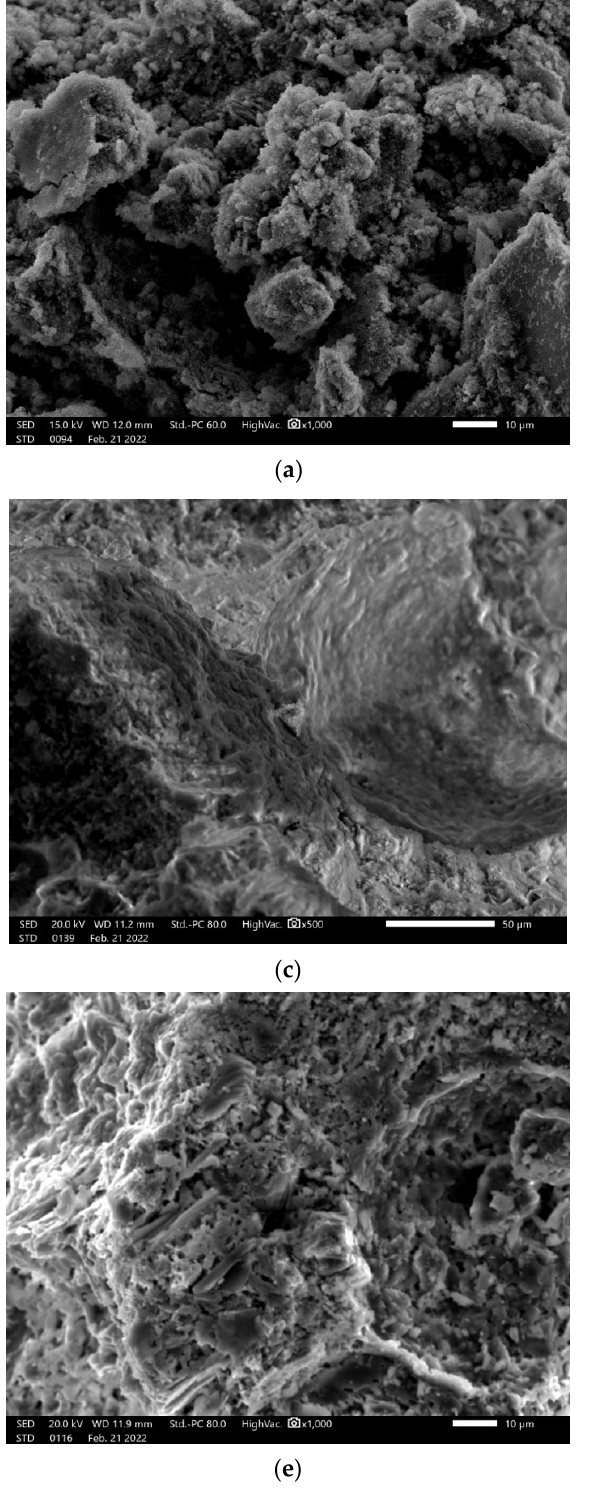
Figure 9. Microstructure of the Al-1 samples after exposure to temperature: ( a ) 20 °C Al-1; ×1000; ( b ) 200 °C Al-1; ×1000; ( c ) 400 °C Al-1; ×500; ( d ) 600 °C Al-1; ×500; ( e ) 800 °C Al-1; ×1000; ( f ) 1000 °C Al-1; ×1000.